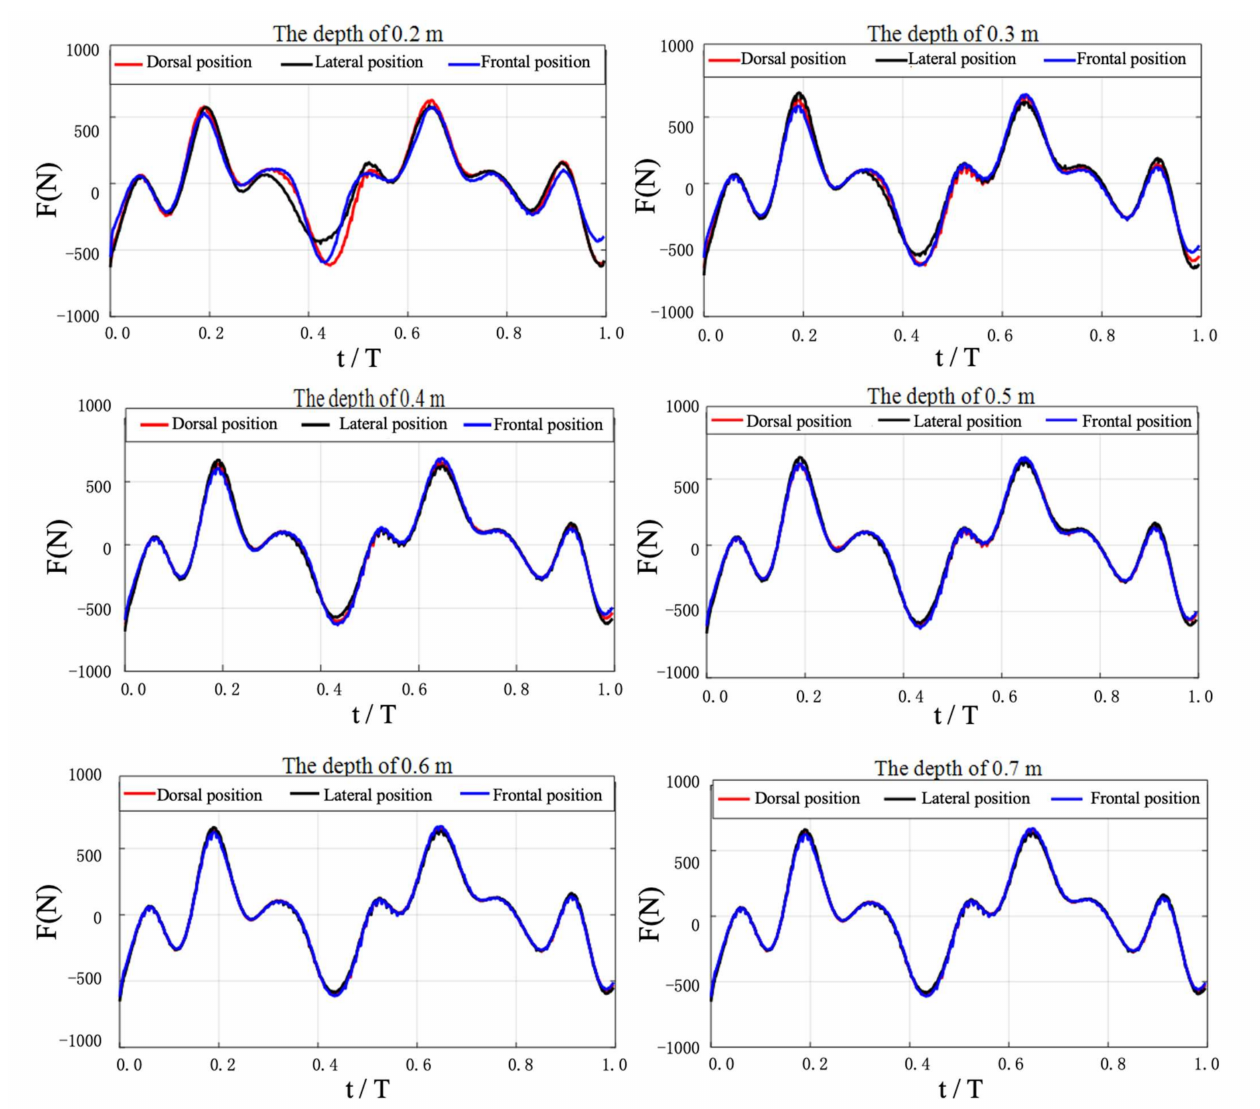
Figure 8. Evolution correspondence between water depth and net streamwise